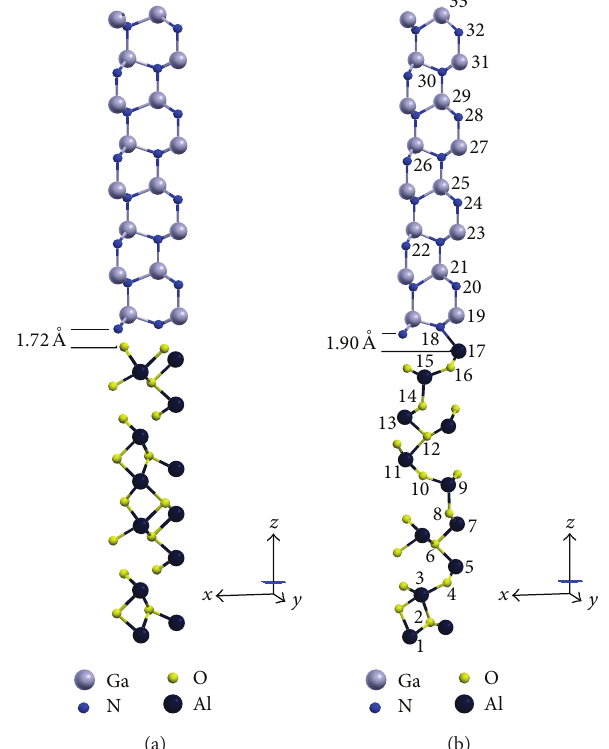
Figure 1: (a) Unrelaxed and (b) relaxed structure of the unit cell of GaN/Al 2 O 3 N-terminated interface.